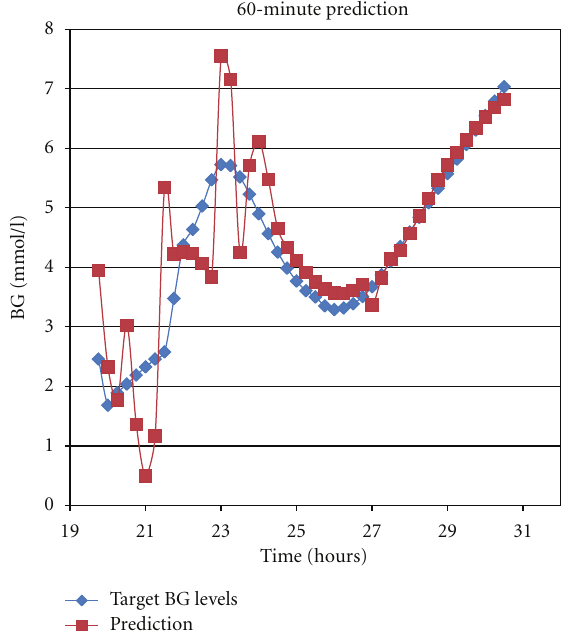
Figure 7: 60-minute prediction results from a day of data not used during AIDA training.